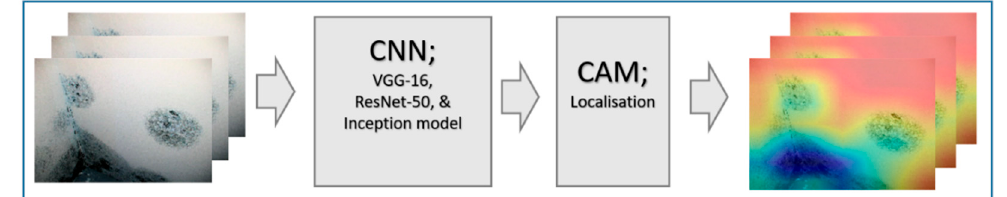
Figure 9. CNN-CAM localisation.